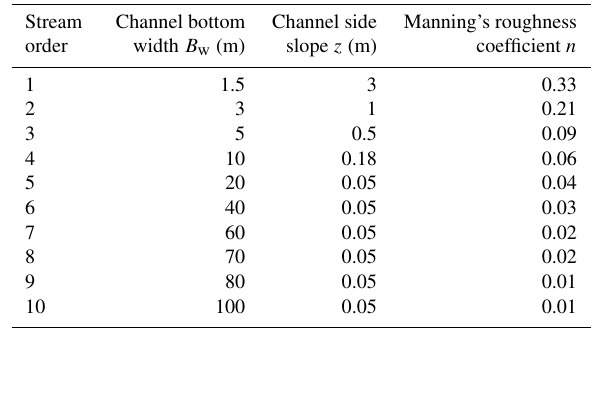
Table B1. Parameters of trapezoidal channels in WRF-Hydro.